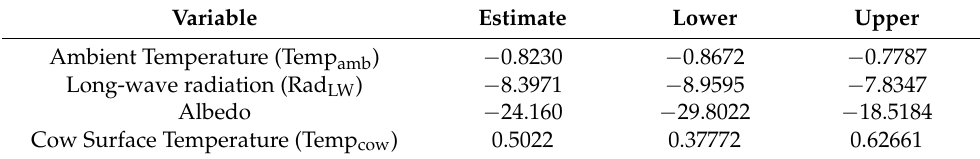
Table 6. Top candidate model parameter estimates and 95% confidence intervals for the difference ( ∆ T) between external surface temperatures of cattle (Temp cow ) and the ambient temperature of the surrounding environment (Temp amb ) for white, red, and black Bos taurus cows near Laramie, WY, USA.